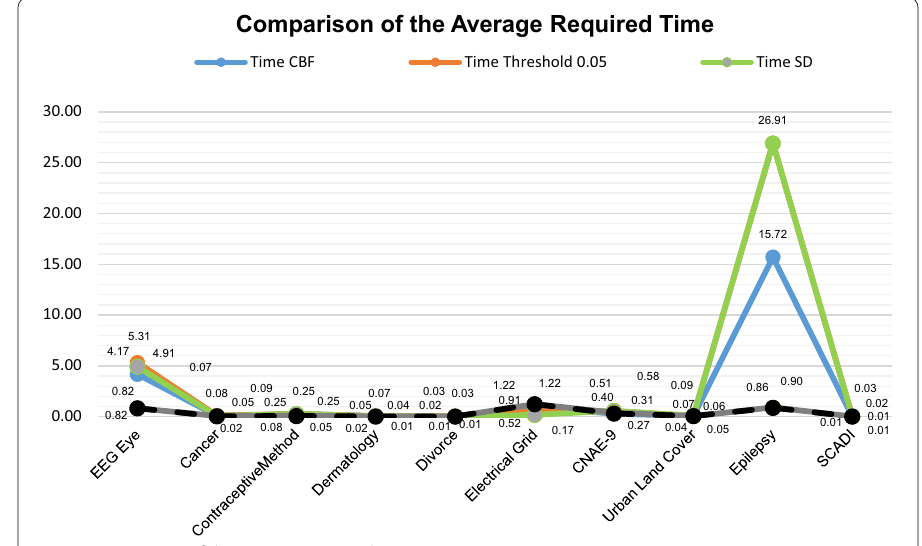
Fig.3 Comparison of the average required time